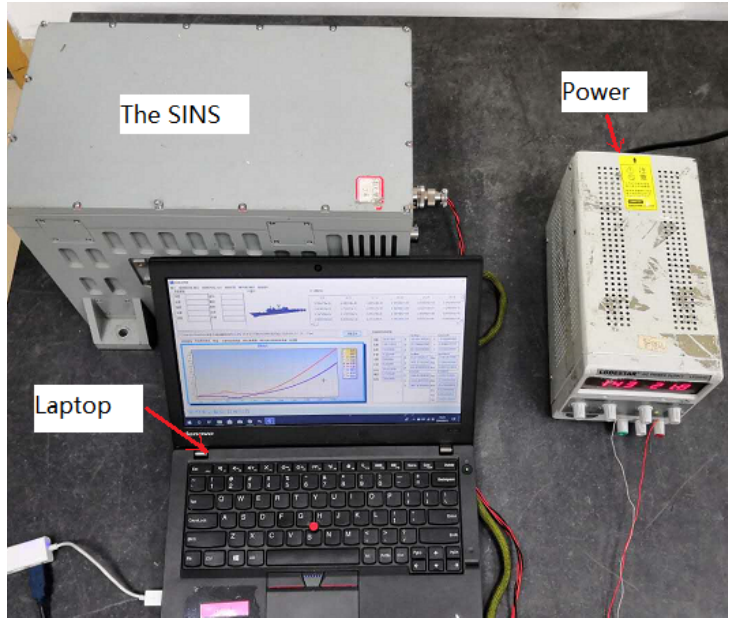
Figure 10. Experimental